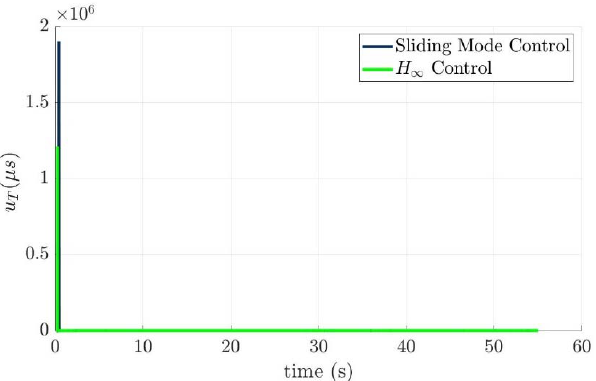
Figure 29. The command histories of the thruster for two control laws, respectively.